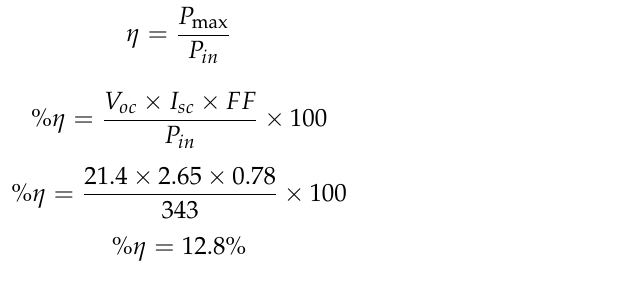
Table 1. Solar panel specification at 1000 W/M 2 and cell temperature 25 °C.